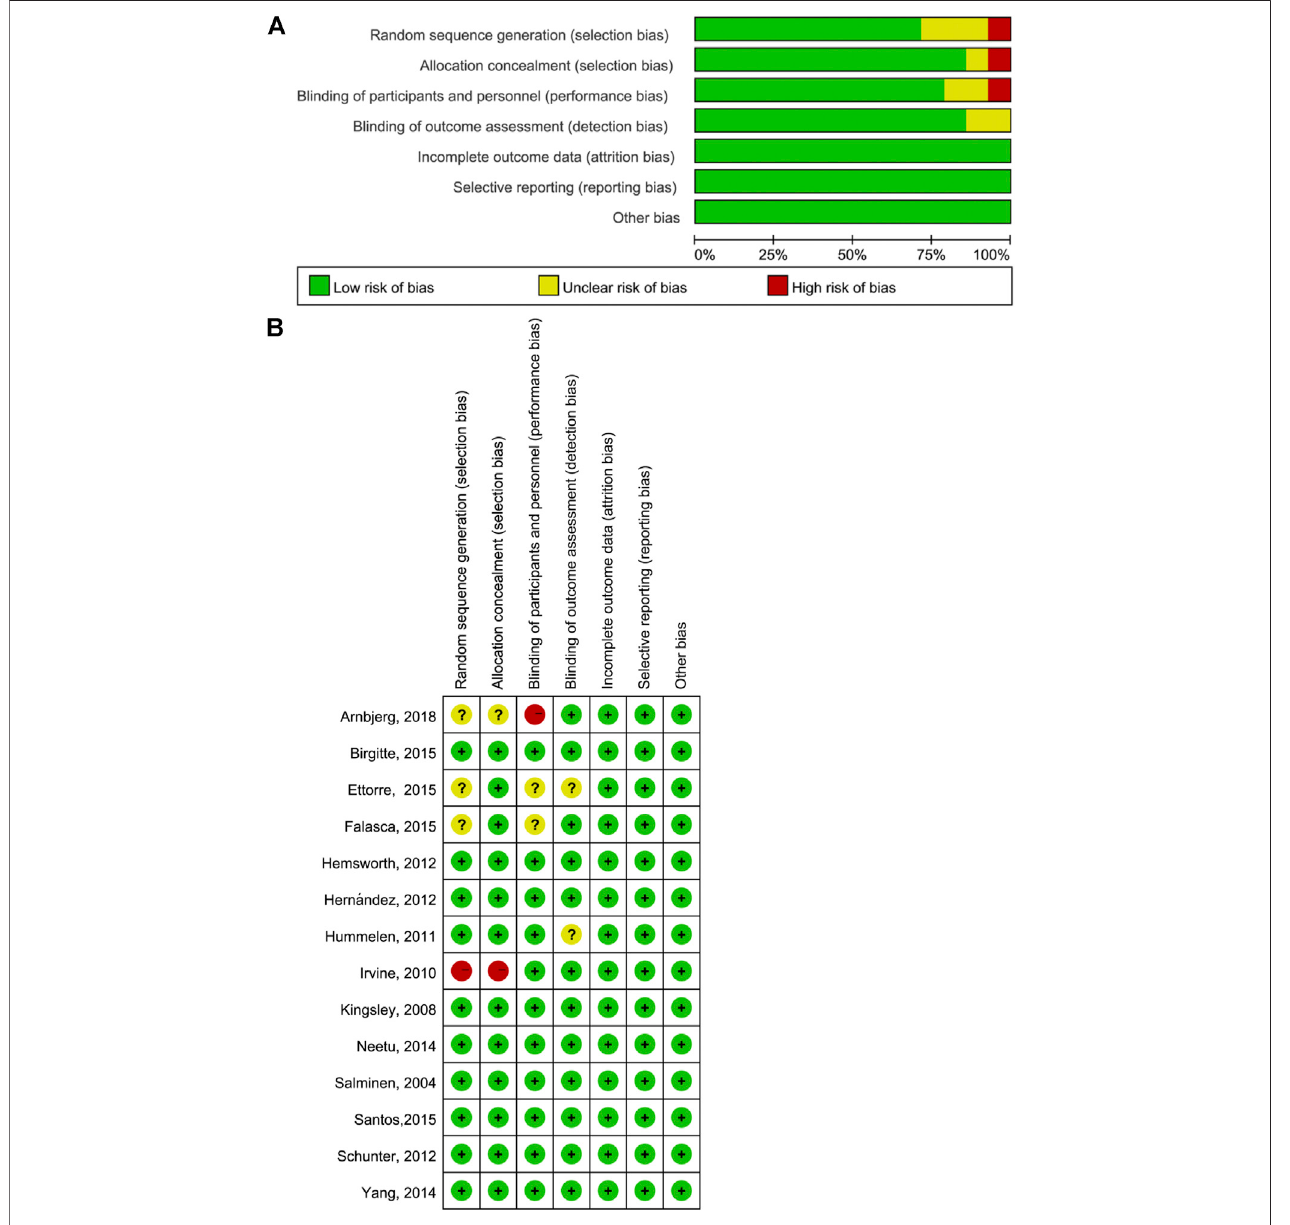
FIGURE 2 | Quality assessment of included literature. (A) Bar chart comparing the percent risk of bias for each study included (B) Risk of bias for each RCT included. The plus signs indicate a low risk of bias, the subtraction signs represent a high risk of bias, and the question marks denote the unclear risk of bias.